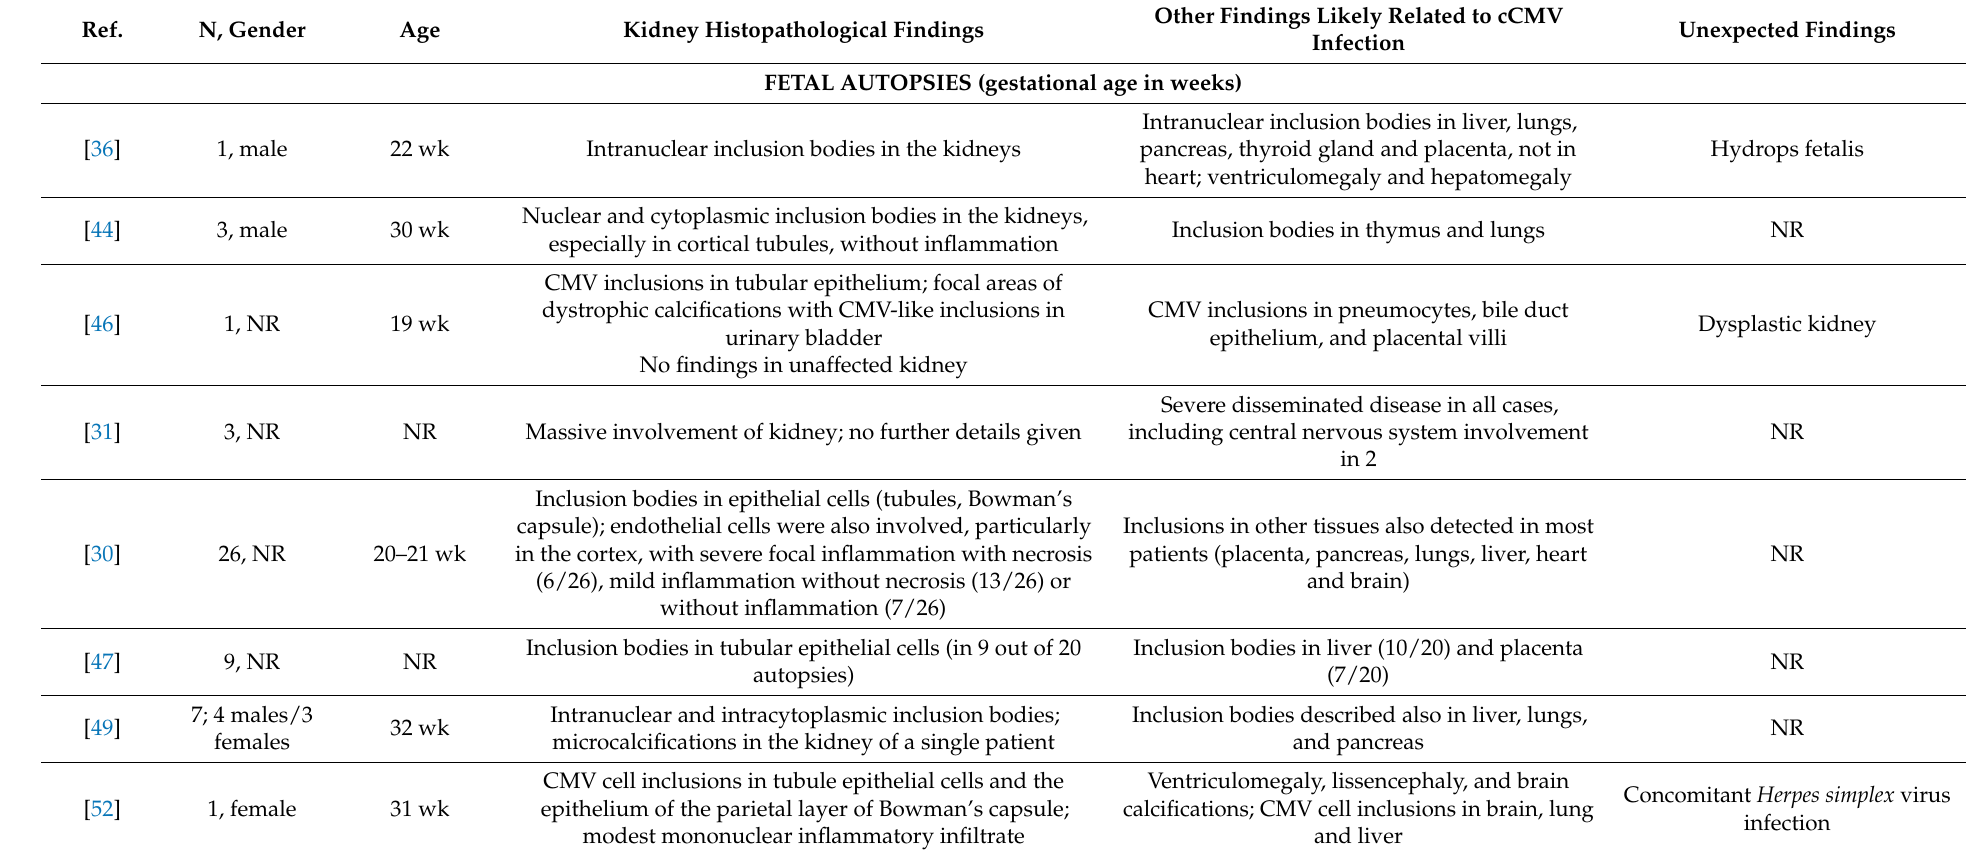
Table 2. Description of the histopathological kidney involvement in patients with cCMV infections.